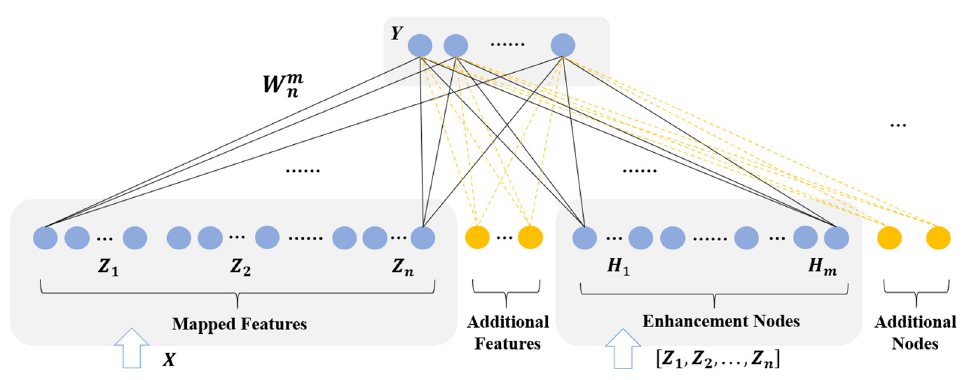
Figure 1. Broad Learning System Structure.